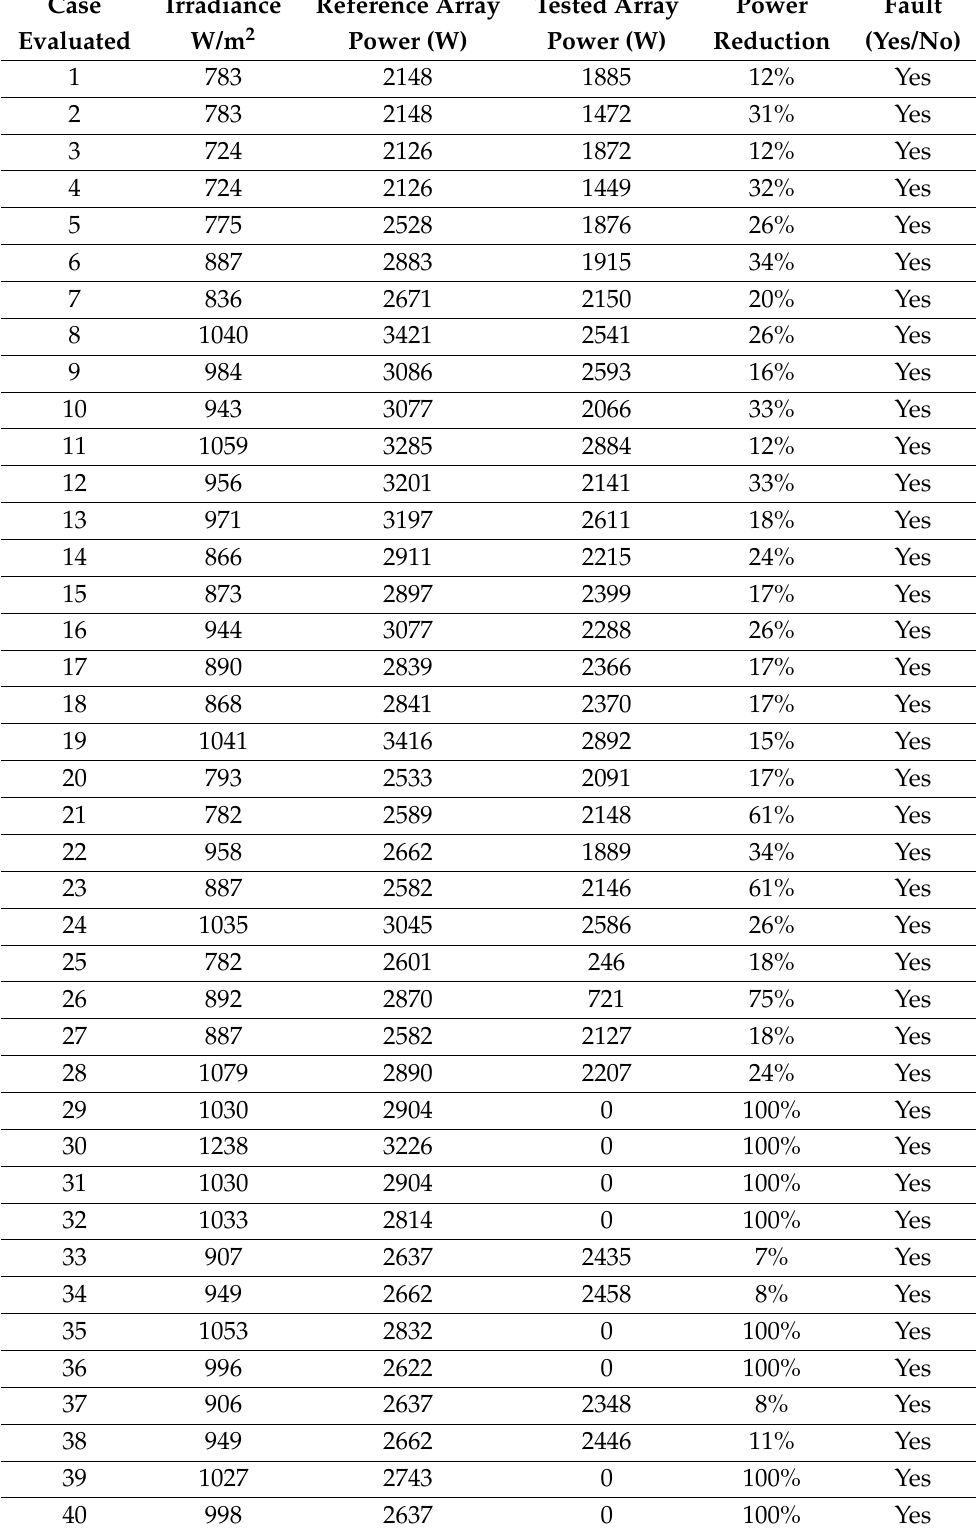
Table 5. Validation of the effect on power of each of the suboptimal conditions evaluated in the experiment.